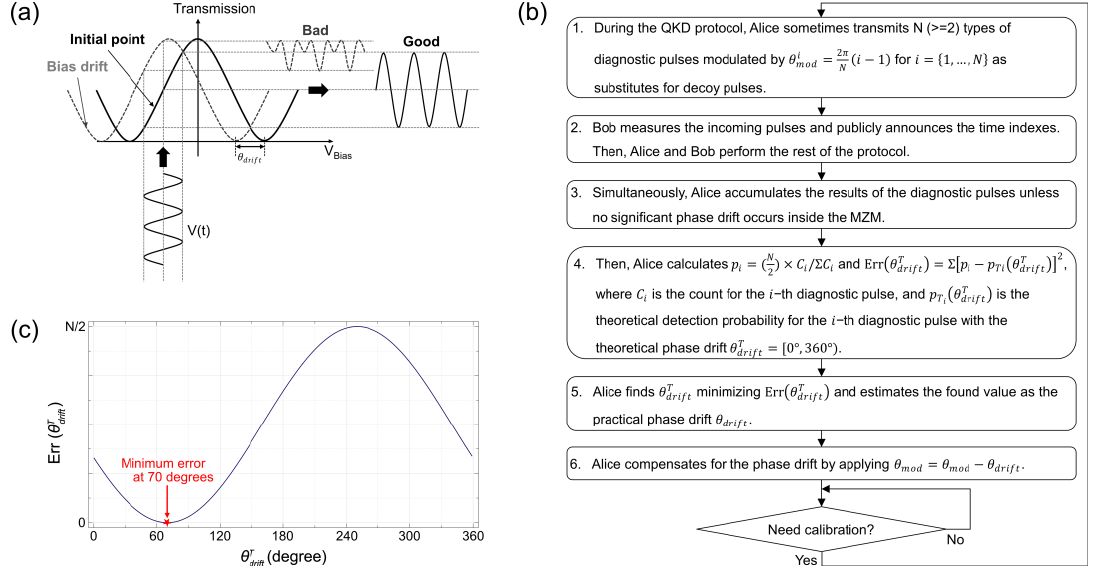
Figure 1. ( a ) Transfer functions of the Mach – Zehnder modulator (MZM) with and without a trans- mission distortion owing to the bias drift 𝜃 𝑑𝑟𝑖𝑓𝑡 ; ( b ) Block diagram of the proposed method applied to a decoy-state BB84 quantum key distribution (QKD) system; ( c ) Calculated Err(𝜃 𝑑𝑟𝑖𝑓𝑡𝑇 ) according to the theoretical phase drift 𝜃 𝑑𝑟𝑖𝑓𝑡𝑇 . The error is minimized when the 𝜃 𝑑𝑟𝑖𝑓𝑡𝑇 maximally matches the practical value 𝜃 𝑑𝑟𝑖𝑓𝑡 . Thus, Alice can estimate 𝜃 𝑑𝑟𝑖𝑓𝑡 = 70° from the minimum error at 𝜃 𝑑𝑟𝑖𝑓𝑡𝑇 = 70° .